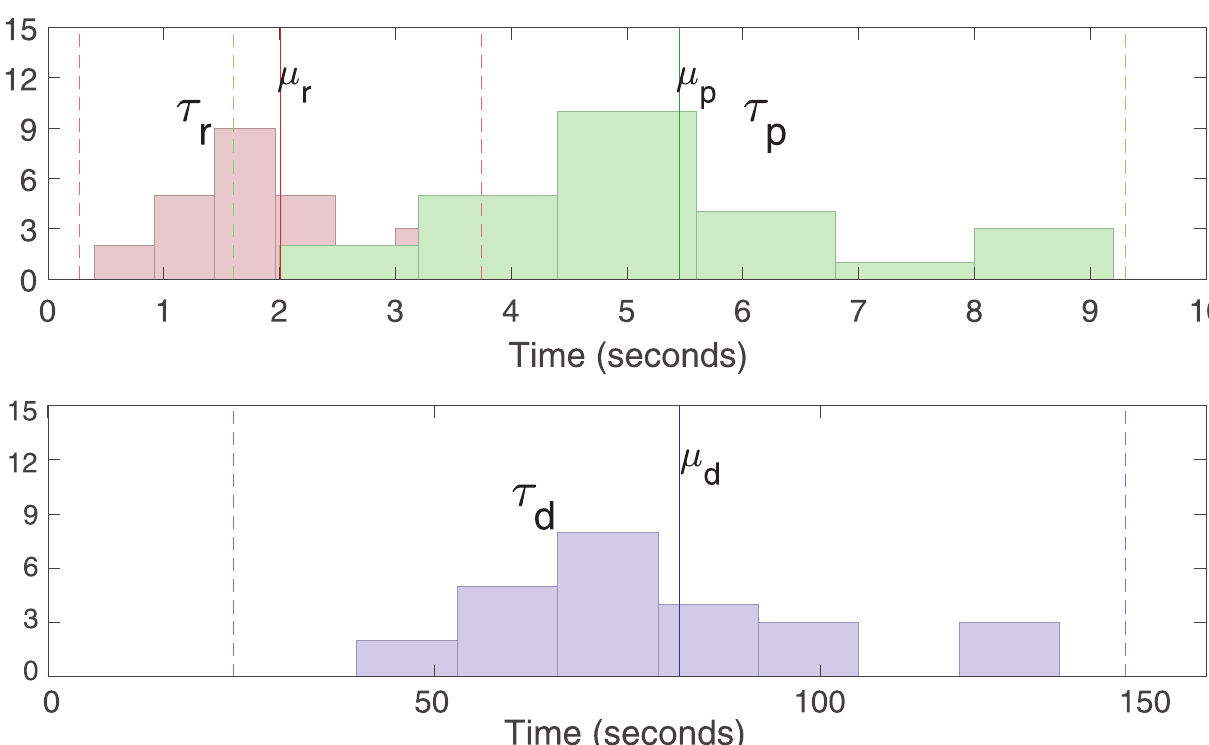
and decay time τ , respectively. Red, green and blue vertical lines correspond to the locations of the means μ r d